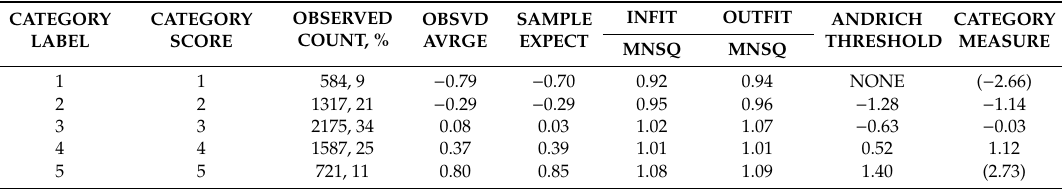
Table 6. Category validity of taekwondo electronic cognition scale.